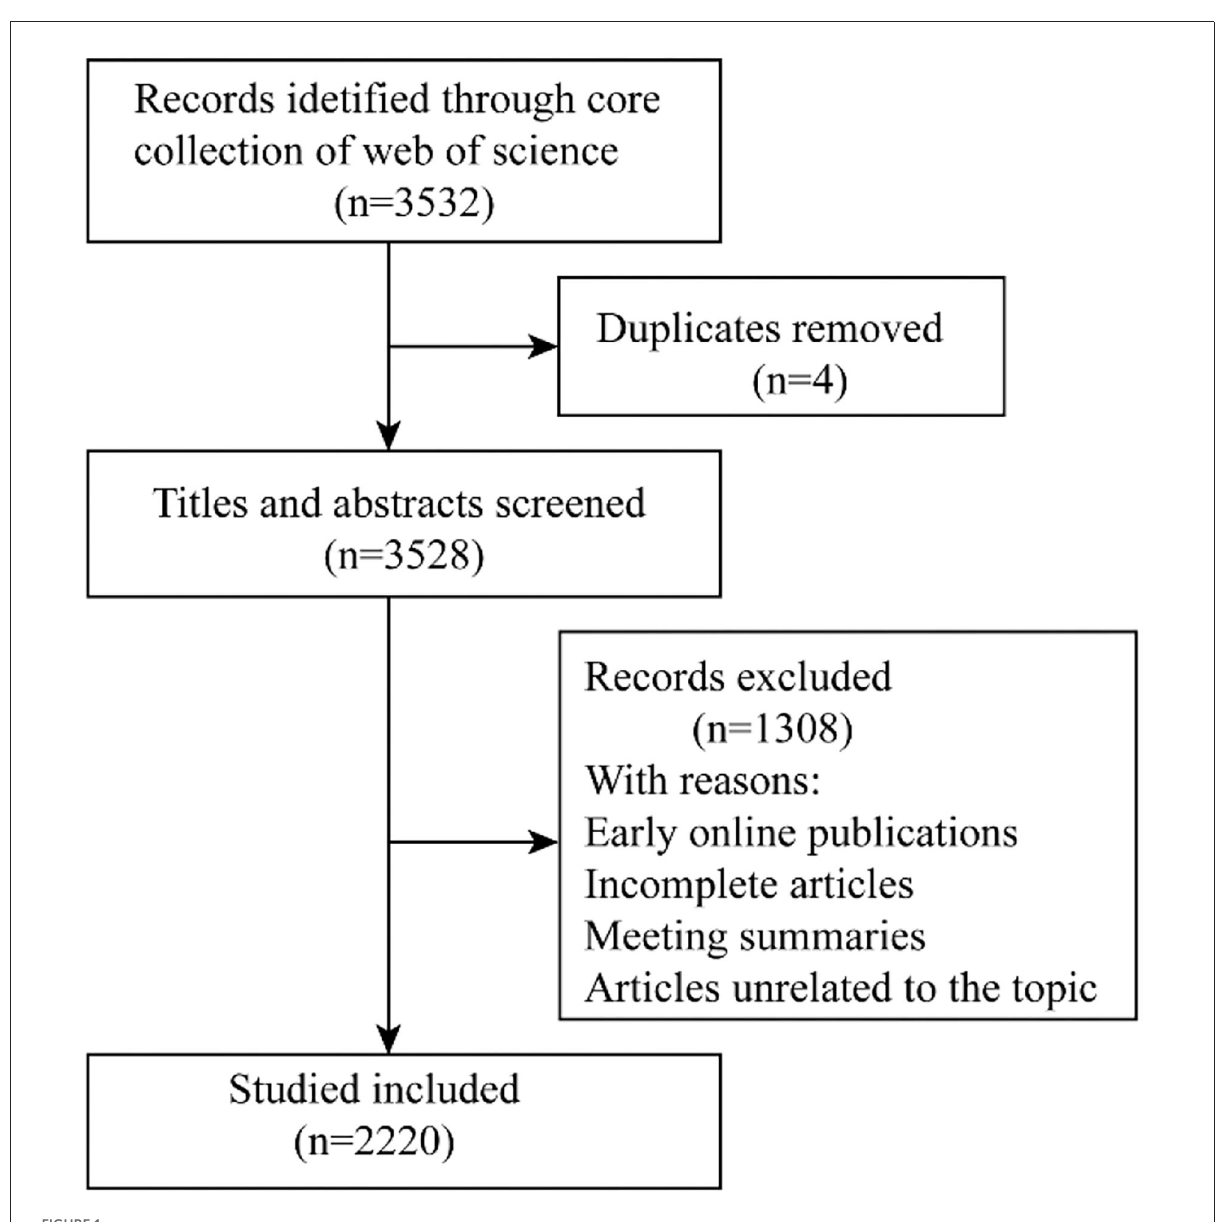
FIGURE1 Flow diagram of study